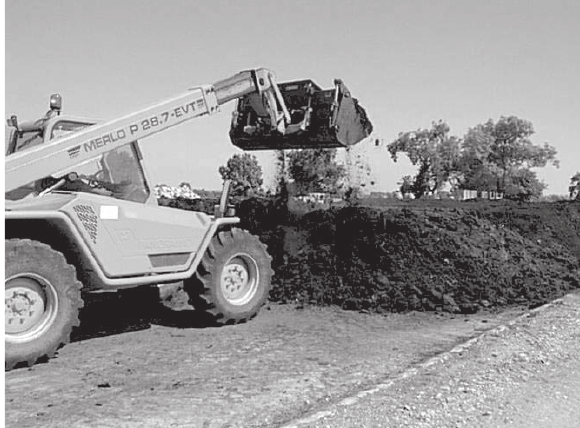
Fig. 2. Turning the ground pruning compost.